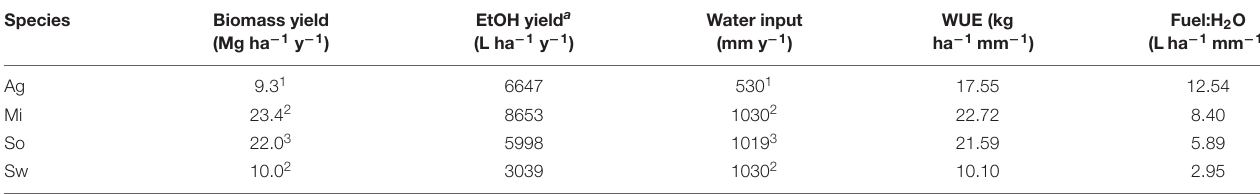
TABLE 3 | Biomass yield (dry) and calculated bioethanol (EtOH) yield a expressed in L (ha y) − 1 for A. americana (Ag) , miscanthus (Mi), sorghum (So), and switchgrass (Sw) with respect to water input (mm y − 1 ), and water use efficiency (WUE) expressed in kg (ha mm) − 1 showing fuel yield to water input (Fuel:H 2 O) ratio.